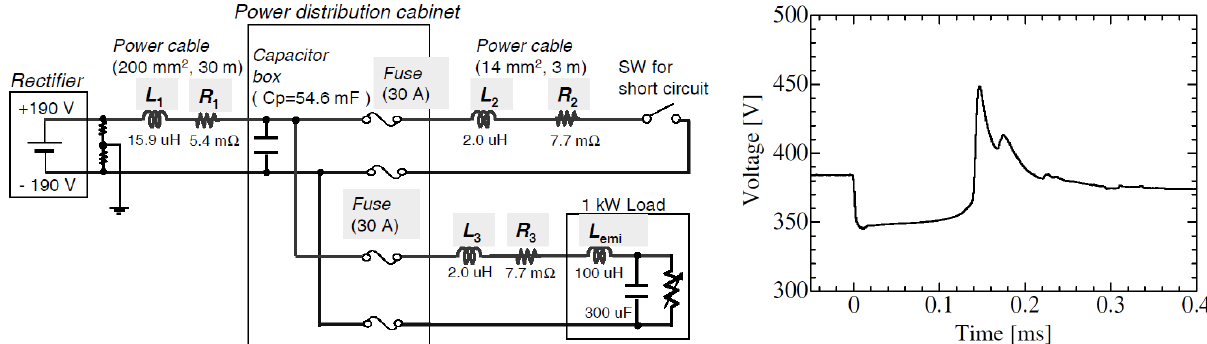
Figure 6. Voltage transient caused by short-circuit at one connected load of a power distribution cabinet with short power cables (EN 300 132-3-1 [125] © ETSI 2011. All rights reserved).